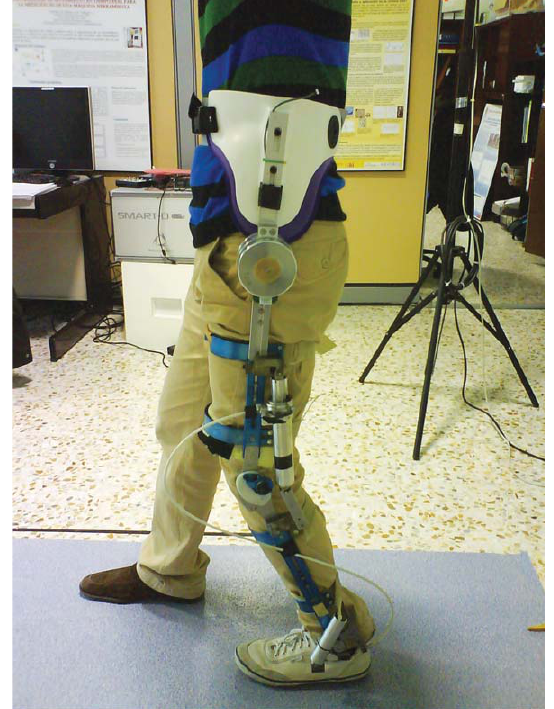
Fig. 10. Lateral view of ESBiRRo HKAFO exoskeleton depicting DC flat motors at the hip, and variable stiffness actuators at knee and